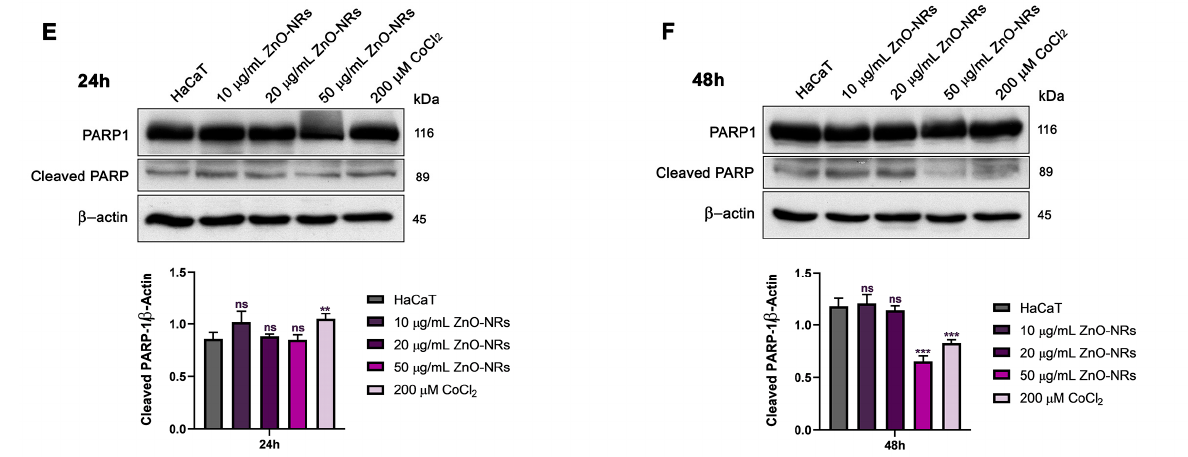
Figure 8. ZnO-NRs’ effects on autophagy and mitophagy in HaCaT cells. HaCaT cells were either untreated or treated with the indicated ZnO-NR concentration for 24 and 48 h. ( A ) BNIP3, LC3I, and LC3II expression after 24 h treatment with 10, 20, and 50 µ g/mL ZnO-NRs. Right side, densitometric analysis of BNIP3, LC3I, and LC3II protein expression. ( B ) TEM images of HaCaT cells treated with 50 µ g/mL ZnO-NRs for 24 h showing the presence of mitophagic vacuoles (black arrows). Size bars, 0.5 µ m. ( C ) TEM images of HaCaT cells treated with 50 µ g/mL ZnO-NRs for 24 h showing the presence of autophagic and mitophagic vacuoles (black arrows). Size bars, 0.5 µ m. ( D ) BNIP3, LC3I, and LC3II expression after 48 h treatment with 10, 20, and 50 µ g/mL ZnO-NRs. Right side, densitometric analysis of BNIP3, LC3I, and LC3II protein expression. ( E , F ) Poly(ADP-ribose) polymerase 1 (PARP1) and cleaved PARP expression after 24 and 48 h treatment with 10, 20, and 50 µ g/mL ZnO-NRs. Den- sitometric analysis is reported below each blot. Experiments were repeated three times. * p < 0.05, ** p < 0.01, and *** p < 0.001. ns, not significant. In all experiments, hypoxia, induced by 200 µ M CoCl 2 , was used as positive control. β -actin was used as loading control.